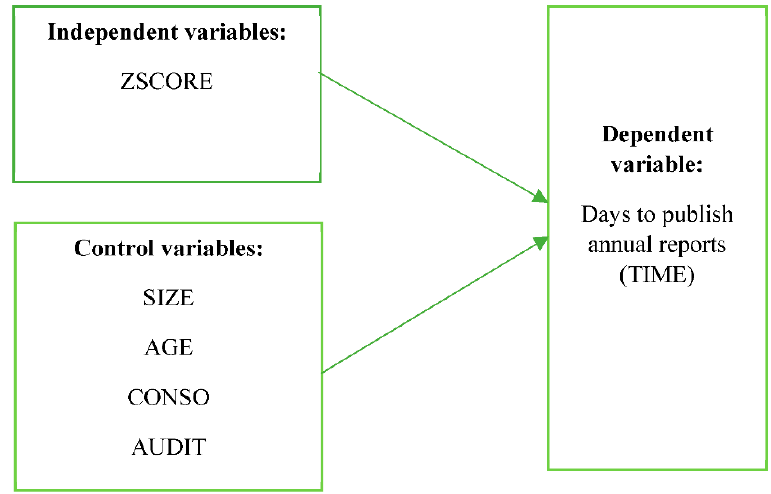
Figure 2. Research model of effect of bankruptcy risk to time for publication annual reports (source: proposed by the authors).